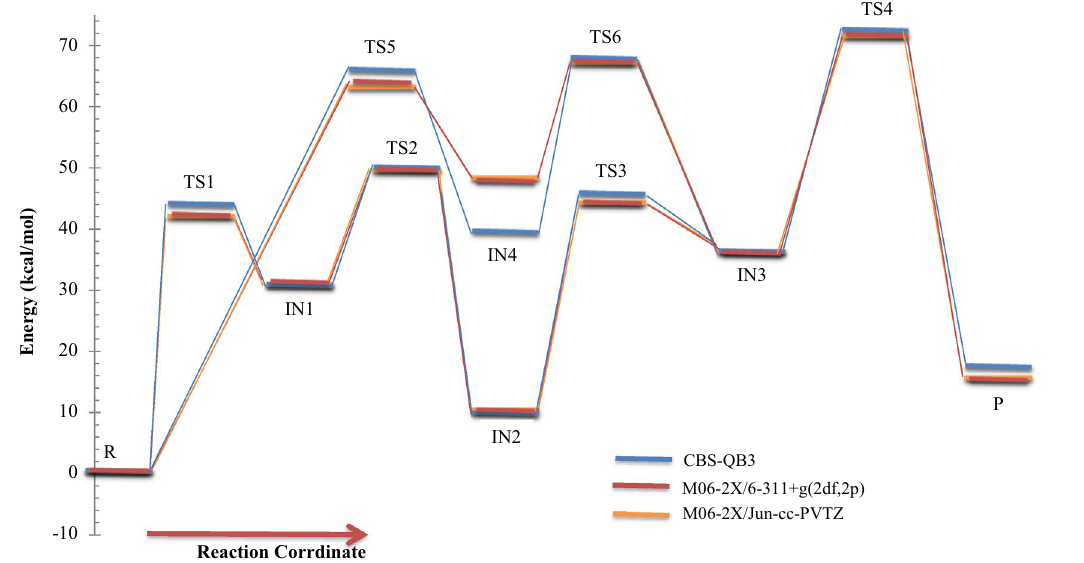
Figure 2. Energy diagram for 3-hydroxyl-1H-pyrrol-2(5H)-one unimolecular reaction computed at the CBS-QB3, M06-2X/Jun-cc-pVTZ, and M06-2X/6-311+g(2df,2p) levels.